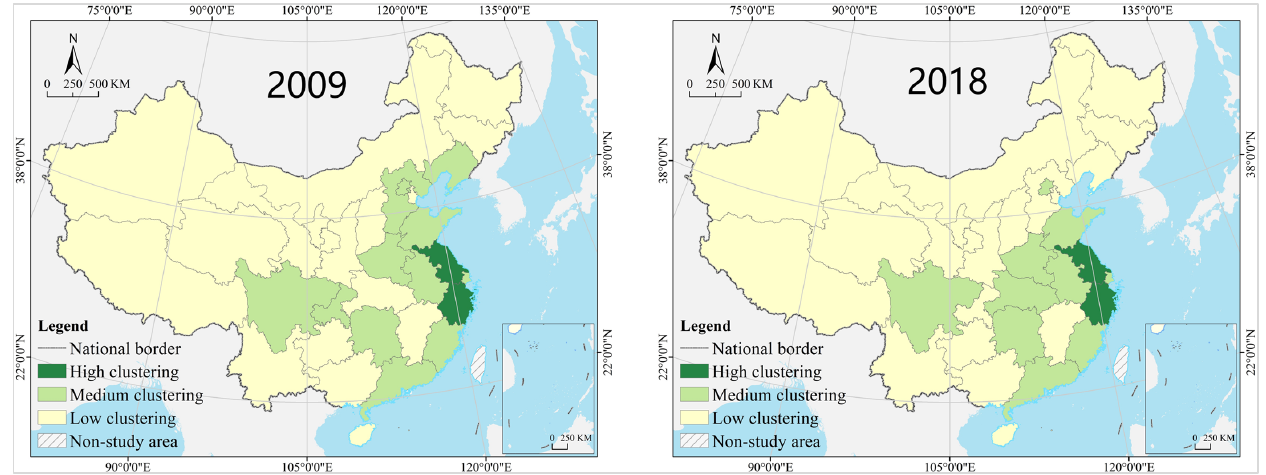
Figure 5. Analysis on the spatial cluster of construction waste in the study area. From 2014 to 2018, there were no provinces in the expansive negative decoupling or weak negative decoupling state, and 58.06% of the provinces were in the weak decoupling state, covering most areas of China, and concentrated in a contiguous distribution in coastal and southwest regions. Inner Mongolia, Liaoning, Jilin, Heilongjiang, Gansu, Ningxia, and Xinjiang were in the recessive decoupling state, mainly distributed in north China. Hebei and Qinghai evolved into strong decoupling provinces, and they were in the best state. Shanghai and Hubei were in the expansive coupling state, while the state of Tianjin and Zhejiang degenerated to recessive coupling and strong negative decoupling, respectively, making them problematic regions (Figure 6).